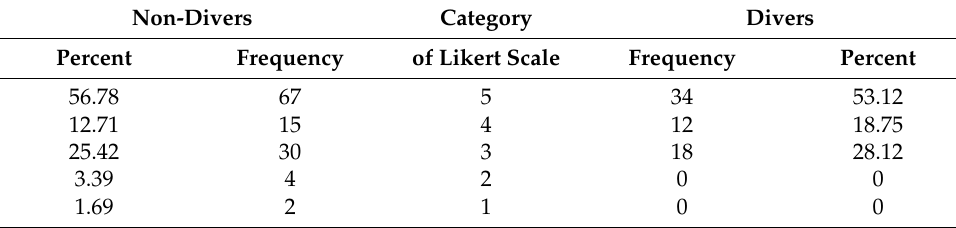
Table 9. Scuba diving impact on the efficiency respiratory